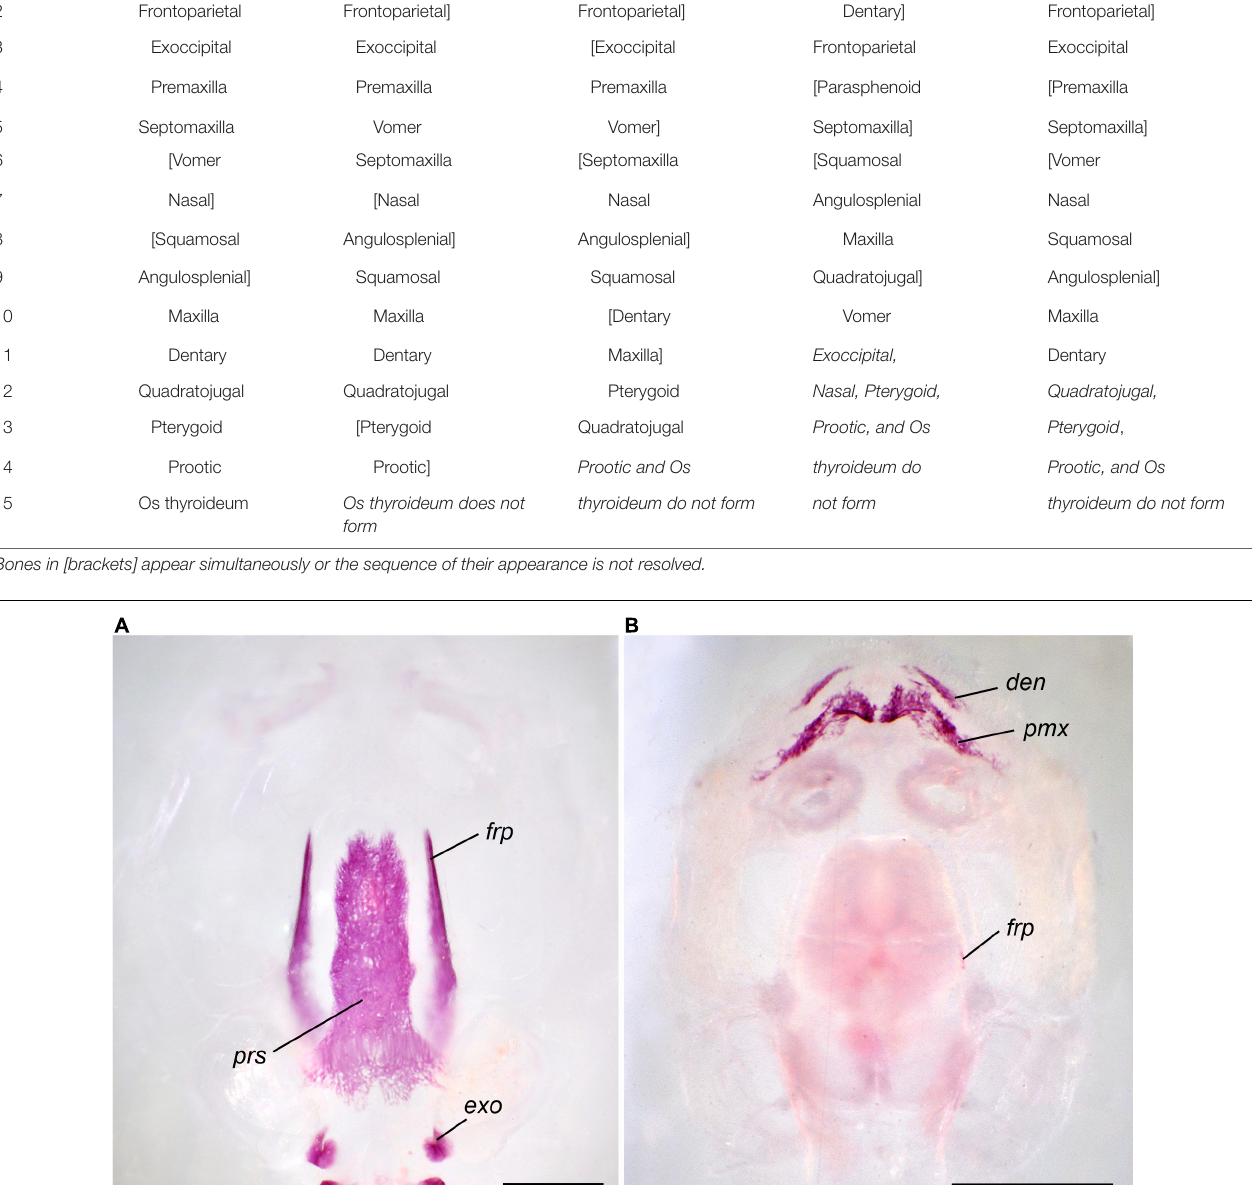
TABLE 4 | Sequence of cranial bones appearance in larval Bombina variegata under different experimental regimes. Sequence position